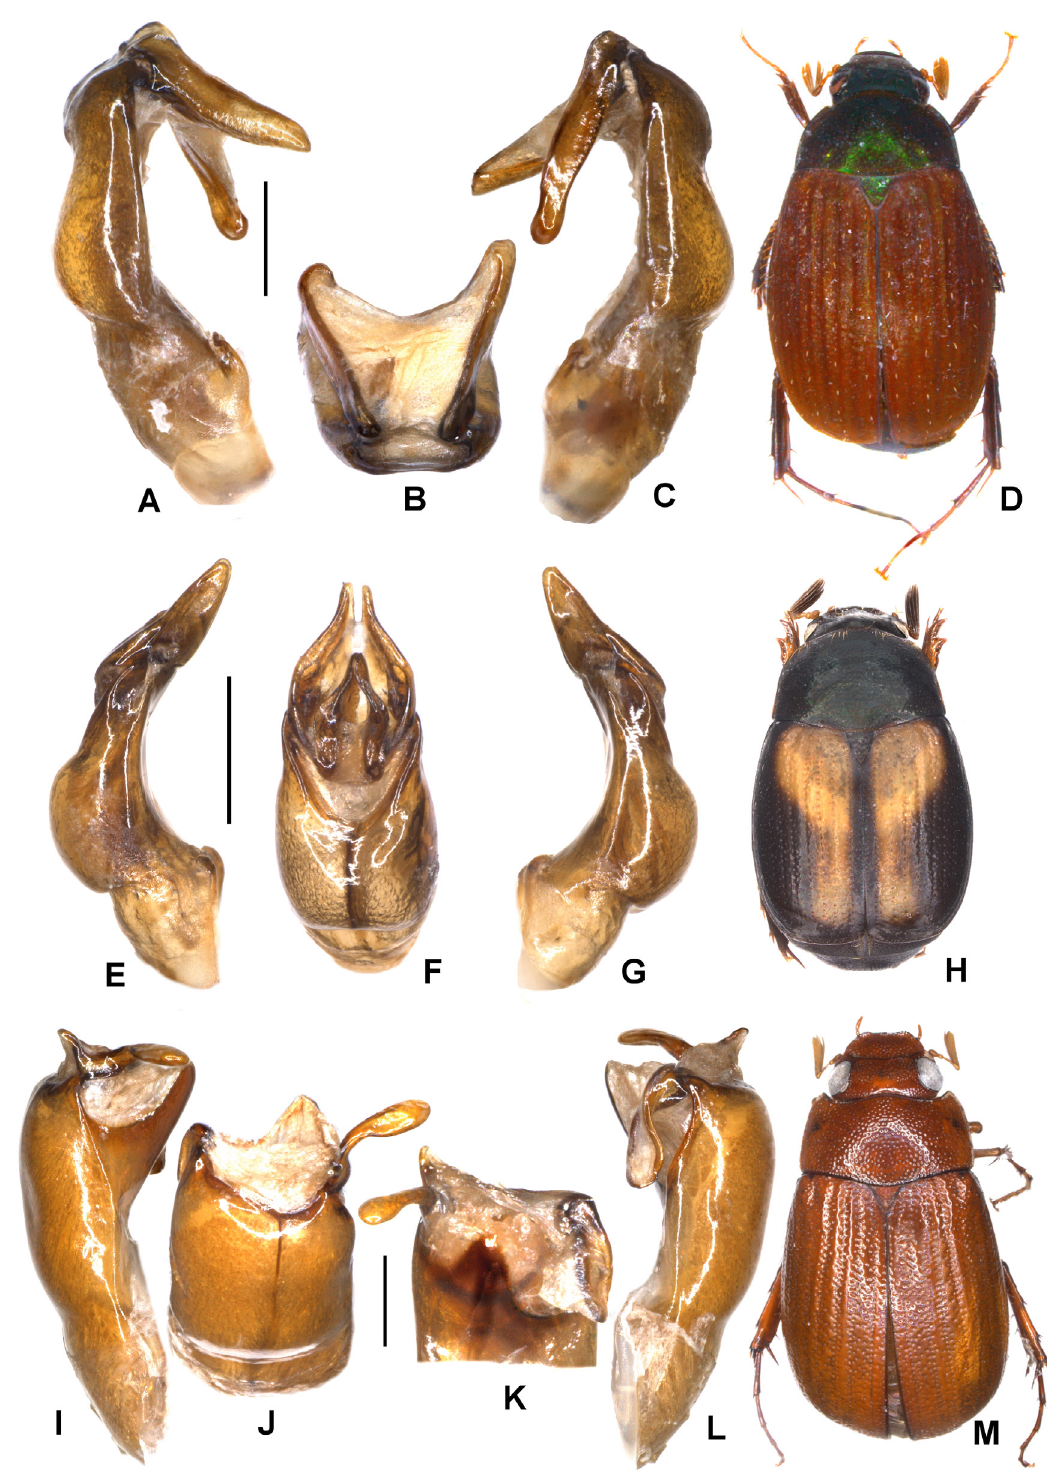
Fig. 3. A–D . Neoserica (s. lat.) reuteri sp. nov., holotype, ♂. E–H . Oxyserica goertzae sp. nov., holotype, ♂. I–M . Selaserica hosanagarana sp. nov., holotype, ♂. A, E, I . Aedeagus, left side lateral view. C, G, L . Aedeagus, right side lateral view. B, F, J–K . Parameres, dorsal view. D, H, M . habitus. Scale bars: 0.5 mm. habitus not to